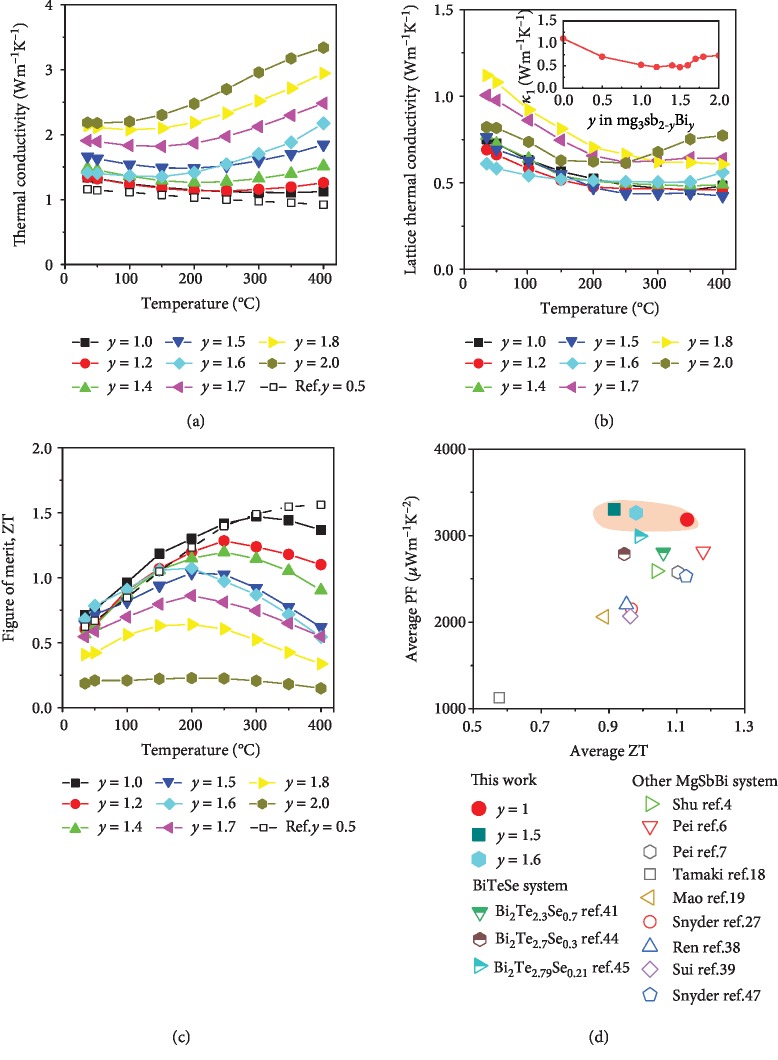
Temperature dependence of (a) thermal conductivity, (b) lattice thermal conductivity (the inset is lattice thermal conductivity as a function of Bi content at 200°C), and (c) figure of merit ZT of Mg3+δSb2-yBiy (y = 1.0, 1.2, 1.4, 1.5, 1.6, 1.7, 1.8, and 2.0), previously reported y = 0.5 as reference [4, 18]. (d) Synergistic improvement of average ZT and average power factor of Mg3+δSb2-yBiy-0.01Te0.01:Mn0.01 solid solutions in the temperature range of 50-250°C, compared with literature reported Mg3+δSb2-yBiy and Bi2 (Te, Se)3 as reference.